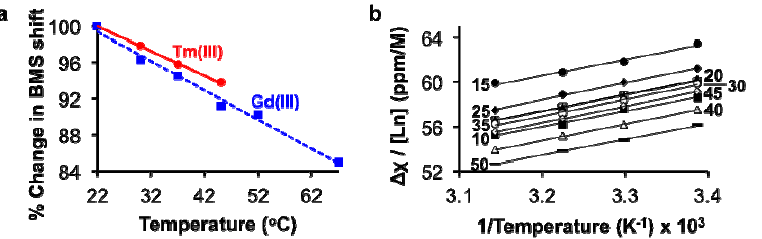
greatest BMS shifts were observed at lowest temperatures. ( b ) The BMS shift, Δ linear dependence on lanthanide ion concentration and inverse temperature, as predicted by theory (Equation (3)). Each line is labeled with is concentration in mM, with labels for data with solid symbols on the left and labels for data with open symbols on the right.